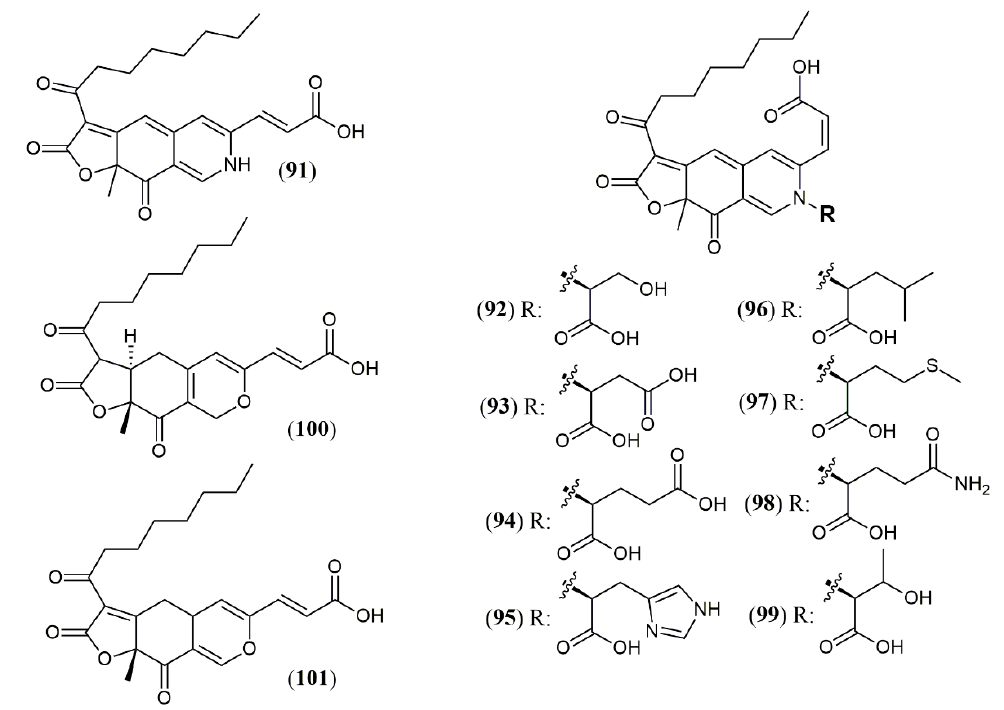
Figure 9. Chemical structures of Talaromyces azaphilones: 91 : trans-PP-O; 92–99 : atrosins S (Ser),D (Asp), E (Glu), H (His), L (Leu), M (Met), Q (Gln), and T (Trp); 100–101 : talaralbols A and B [32, 58].